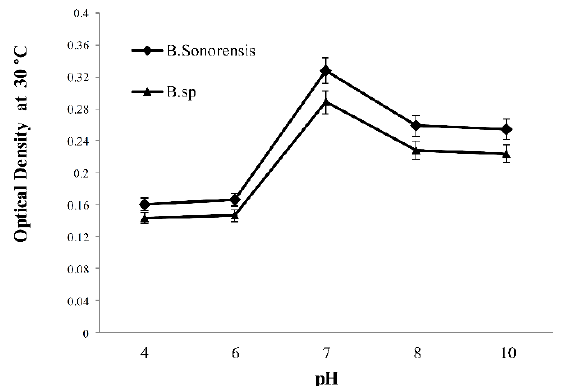
Fig. 3. Growth (optical density) of B. Sonorensis and B . sp. at 30 °C in different pHs (48 h)